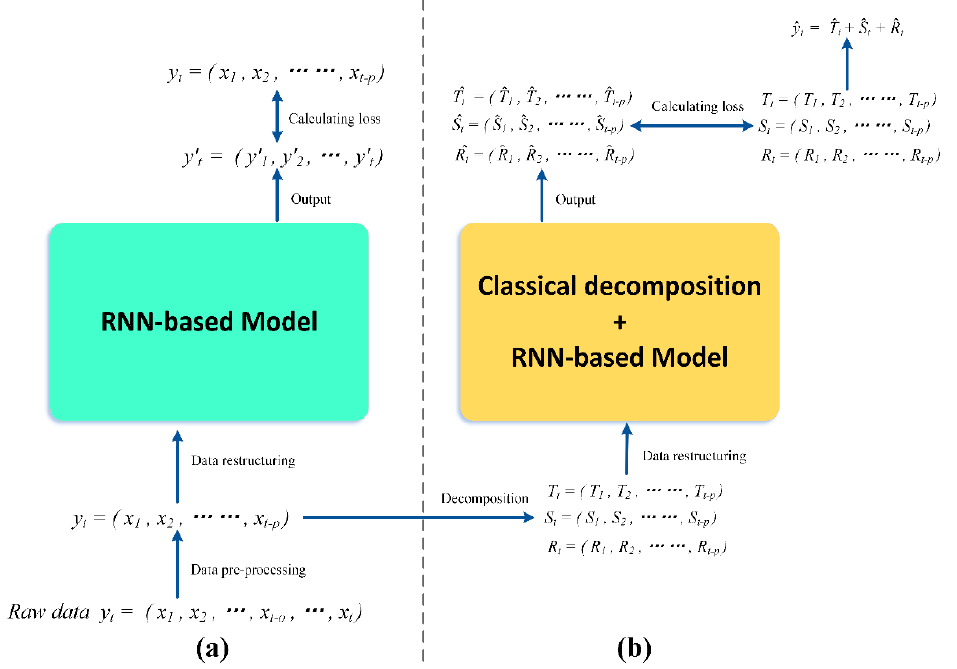
Figure 6. Comparison of two methane concentration prediction methods. ( a ) is RNN-based Model only and ( b ) is RNN-based optimization model based on time series Classical decomposition methods.